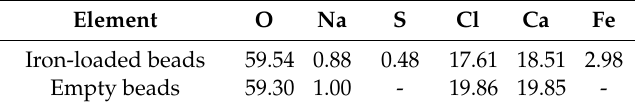
Table 3. Surface composition (wt%) of iron-loaded and empty alginate beads determined by energy dispersive X-ray spectroscopy